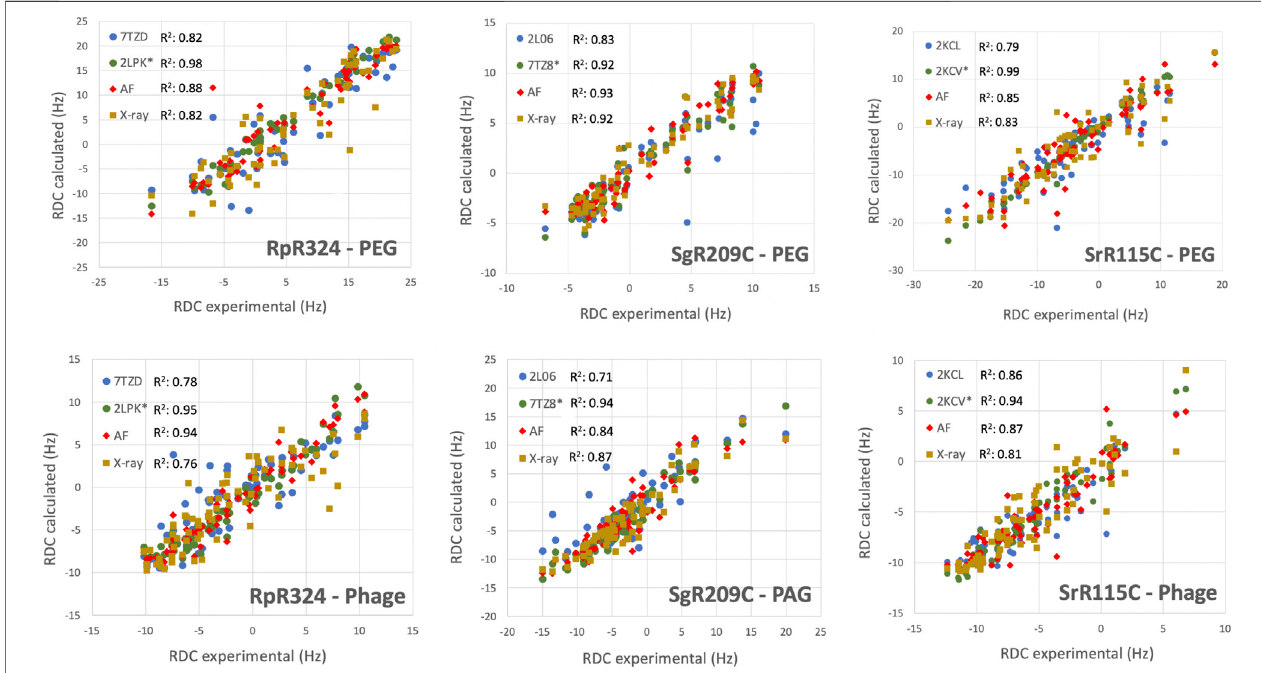
FIGURE6 | AF structures have excellent fi tto RDC data. Comparison of experimentally measured 15 N- 1 H RDC data (plotted on x-axis) and values computed from experimental or prediction models using PDBStat (Tejero et al., 2013). The data points are for (blue) NMR models determined without RDC data, (green) NMR models re fi ned with 15 N- 1 H RDC data, (red) AlphaFold prediction models, and (gold) X-ray crystal structures. For NMR and AlphaFold model ensembles, the medoid conformer of the well-de fi ned regions (as indicated in Table 1 ) were compared. The linear correlation coef fi cient (R 2 ) for each data set is shown in the inset.